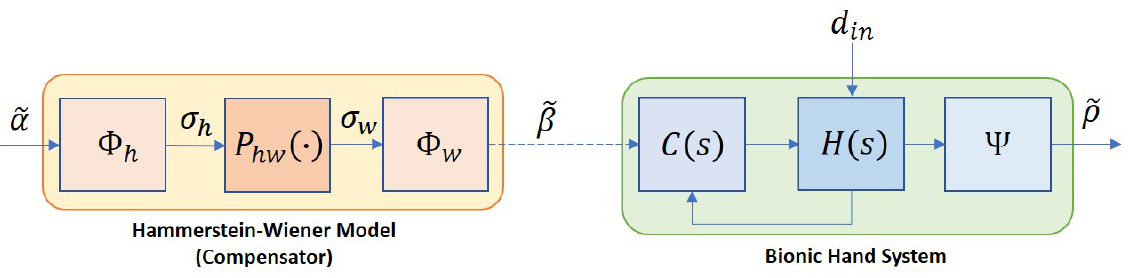
Figure 11. Overall control system structure with the Hammerstein–Wiener